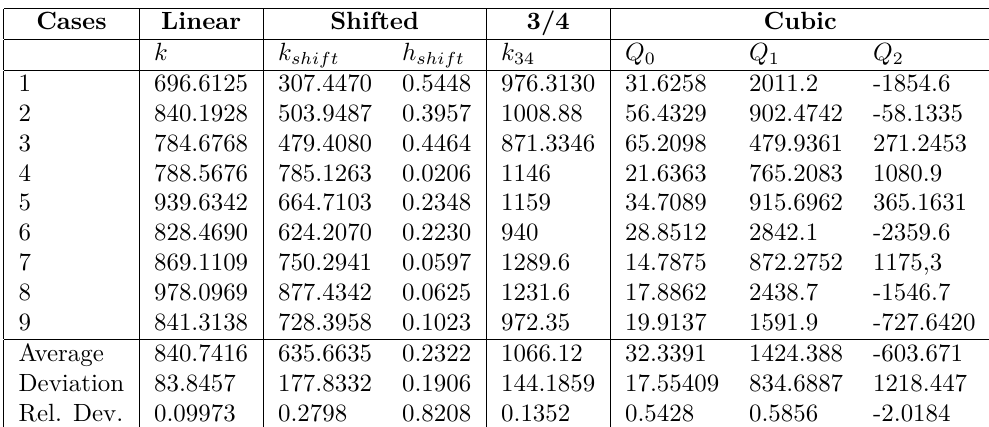
(cid:2) (cid:3) N / mm 2 , h shift [mm], shift